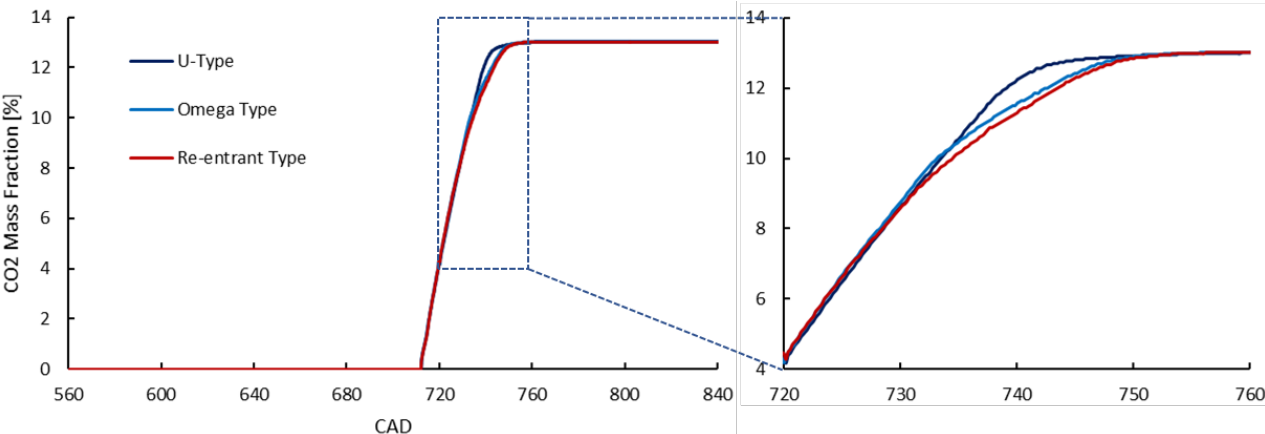
Figure 15. CO 2 emissions diagrams for the three various piston types.